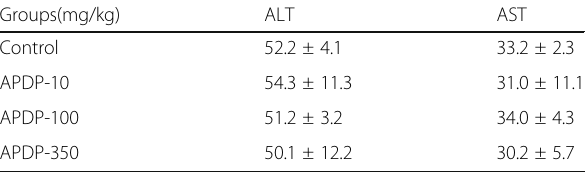
Table 2 Effect of 1-(2-(2-(2-(1- aminoethyl)phenyl)diselanyl)phenyl)ethanamine (APDP) on ALT (alanine transaminase) and AST (aspartate transaminase) in mice Groups(mg/kg)